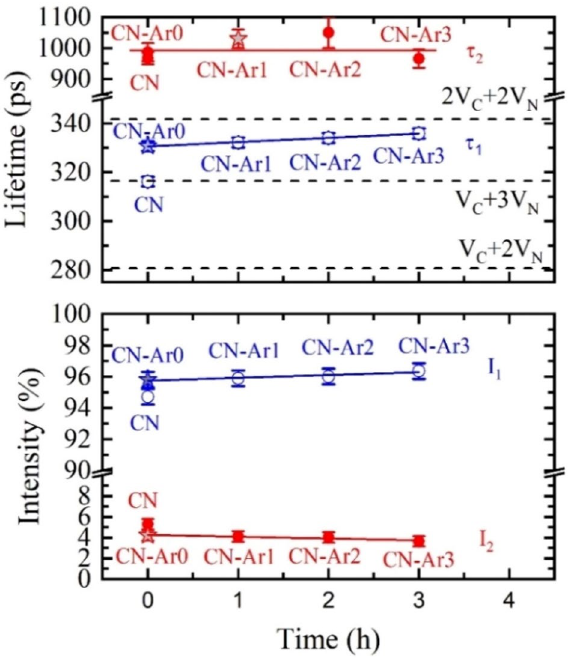
Figure 14. Dependence of lifetimes and intensities of individual components on annealing time in argon. Horizontal dashed lines show calculated lifetimes for different types of defects.